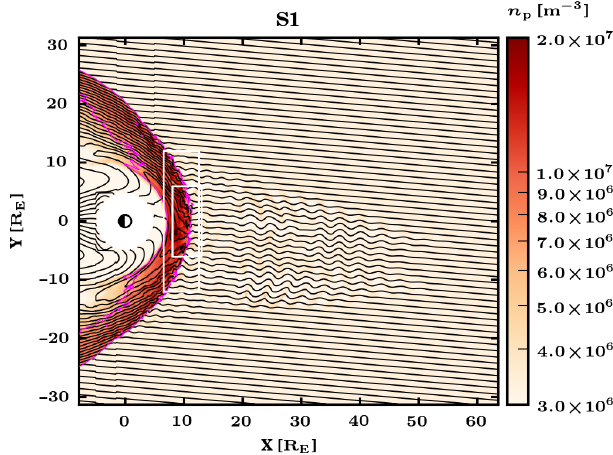
Figure 1. Overview of the Vlasiator simulation S1 ( B IMF = 5nT and M A = 10) at time t = 500s, with proton number density (colour map) overlaid with an estimate of the bow shock position ac- cording to plasma compression (fuchsia curve, n p > 2 n p , sw ). Also shown are magnetic field lines (black curves) and two white over- lapping rectangles indicating zoomed-in regions used for the analy- sis of local bow shock structure (smaller rectangle) and test-particle studies (larger